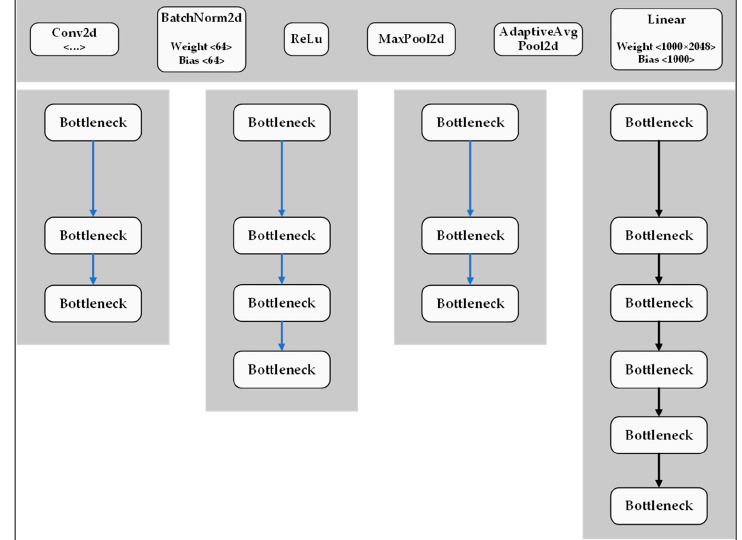
Figure 11. Structure of ResNet-50 model.